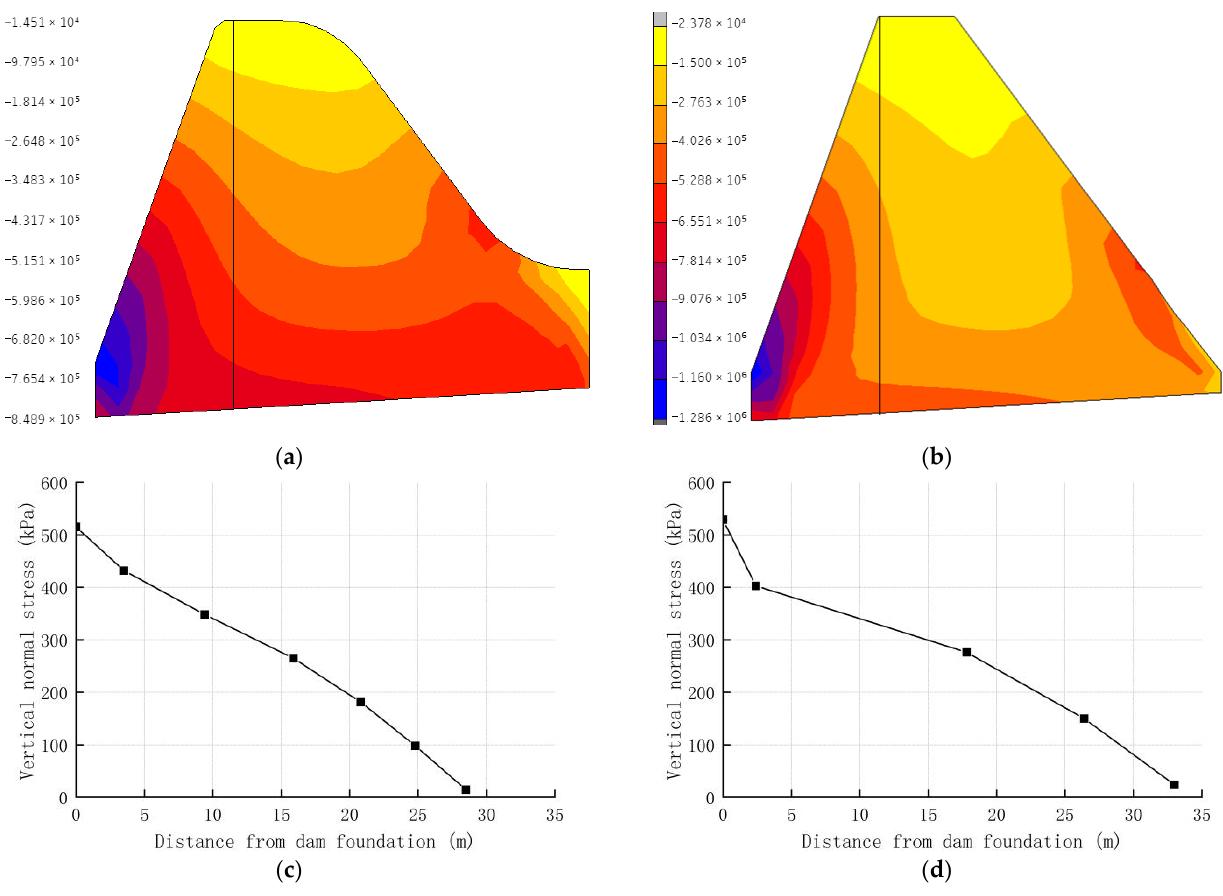
Figure 4. Diagram of the vertical normal stress of the dam: ( a ) overflow dam section (Pa); ( b ) non - overflow dam section (Pa); ( c ) vertical normal stress distribution diagram of the overflow dam axis cross - section; and ( d ) vertical normal stress distribution diagram of the non - overflow dam axis cross-section.